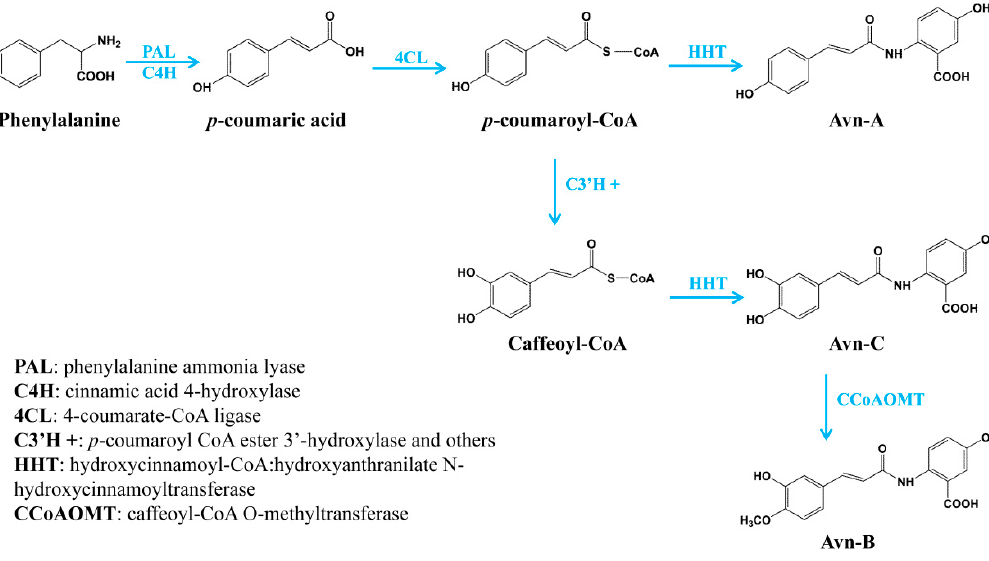
Figure 5. The complete biosynthetic pathway of three major avenanthramides in oat.